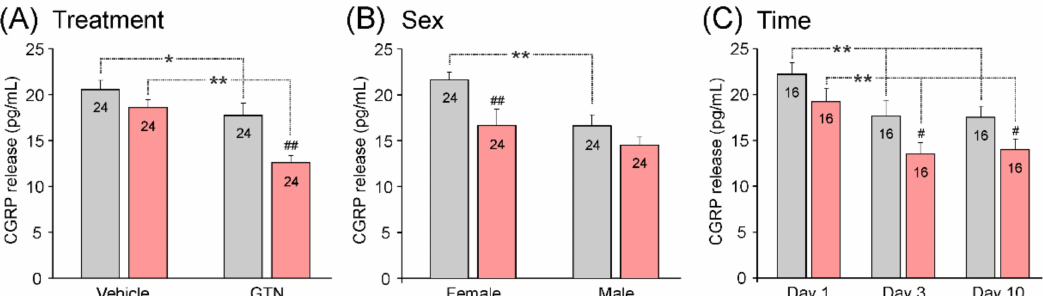
Figure 2. Basal CGRP release from the dura mater of animals treated with control antibody (grey) or fremanezumab (red) depending on injection of vehicle or GTN ( A ), animal’s sex ( B ), and waiting time (day) after antibody treatment ( C ). Data are means ± SEM of averaged release values measured at 5 and 10 min; numbers of experiments shown in the columns; and significant differences between groups (factorial ANOVA and Tukey post hoc test, *: p < 0.01, **: p < 0.001) as well as between control antibody and fremanezumab (# p < 0.05, ## p < 0.001).